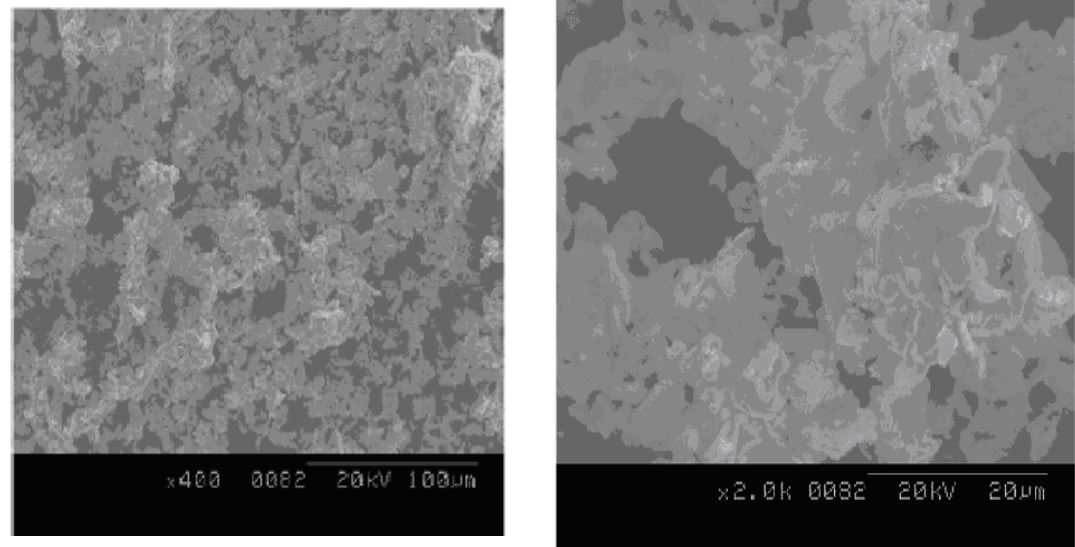
Figure 7. SEM photographs (with different magnifications) of Ni nanofibers after Ag coating for 4 h: at low magnification (left), and at high magnification (right).